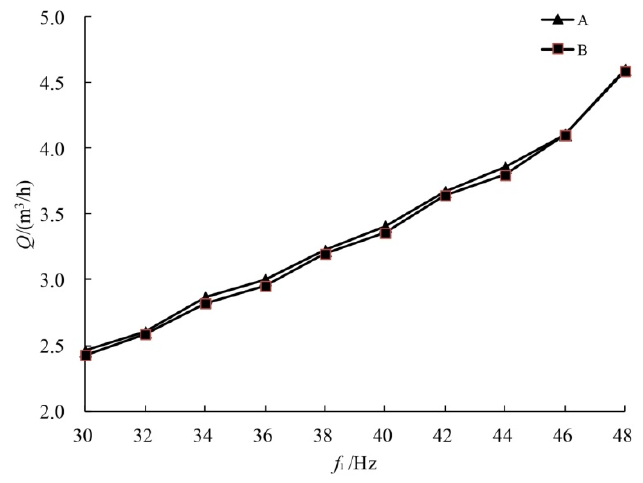
Figure 11. Variable frequency flow curve